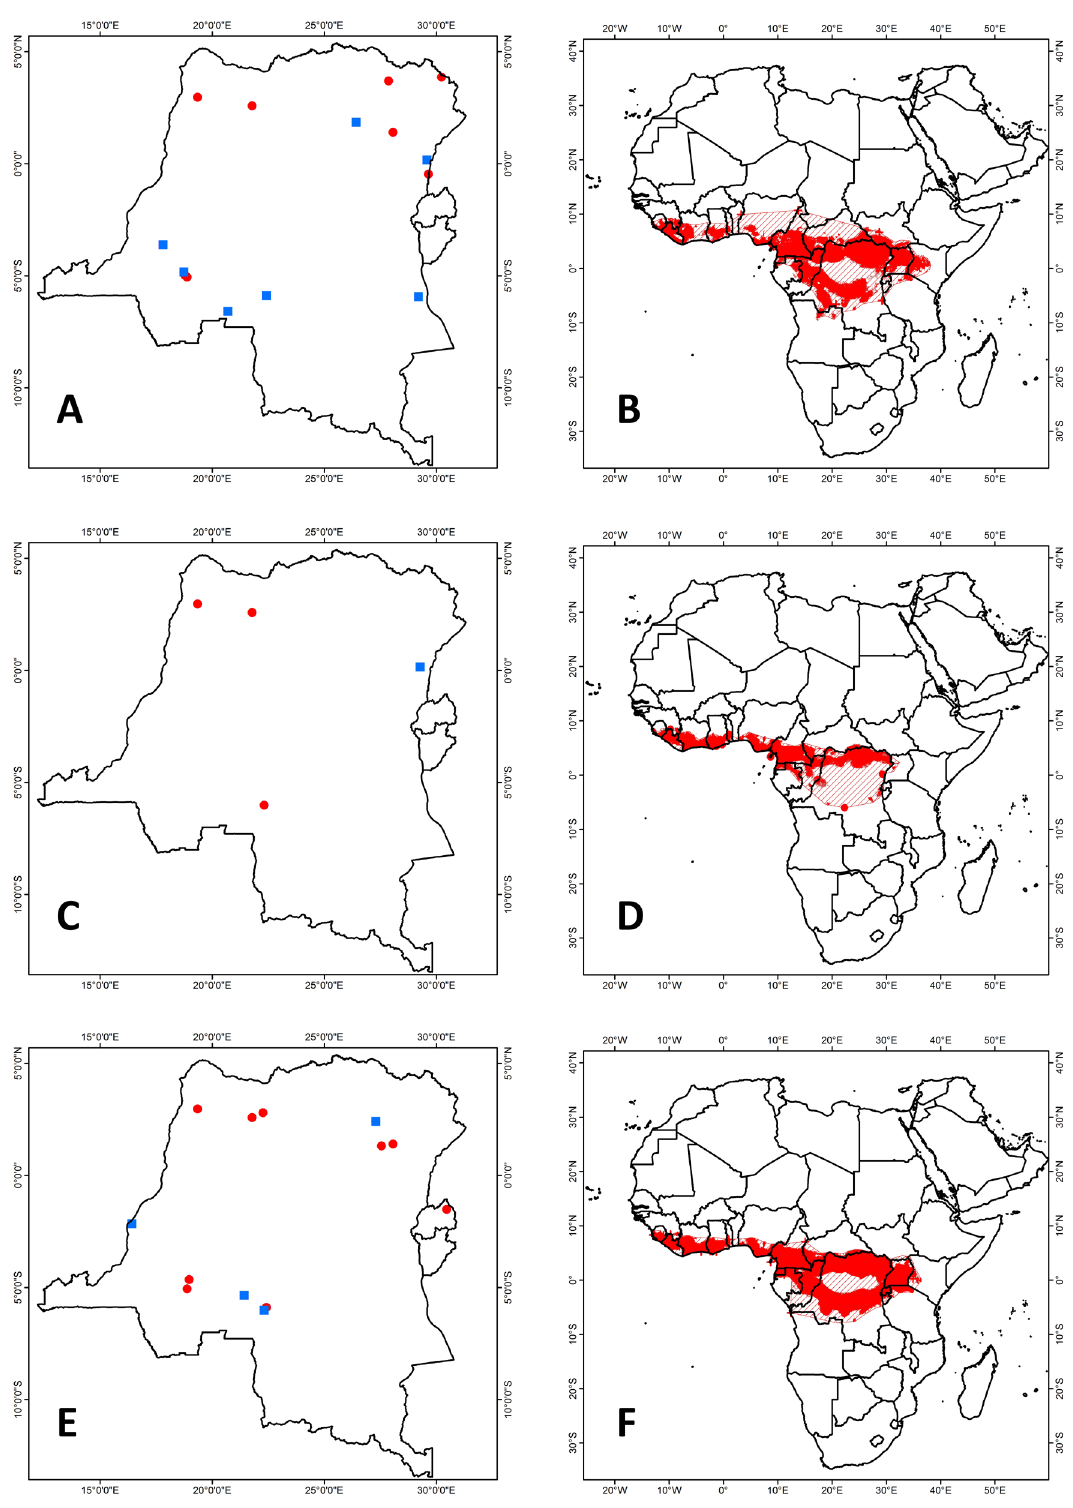
Fig. 30. Distribution maps. A–B . Mops (Xiphonycteris) nanulus J.A. Allen, 1917. C–D . Mops (Xiphonycteris) spurrelli (Dollman, 1911). E–F . Mops (Xiphonycteris) thersites (Thomas, 1903). A, C, E. Distribution in the CRB area. B, D, F.